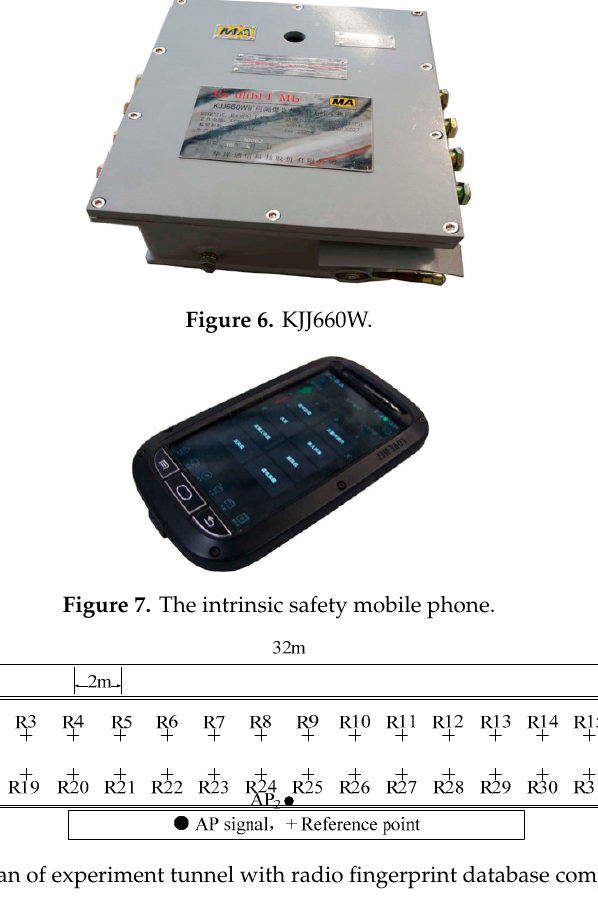
( f ) Figure 9. Comparison of radio fingerprint samples statistical distribution between the adaptive radio fingerprint database and the traditional radio fingerprint database: ( a ) mean value of